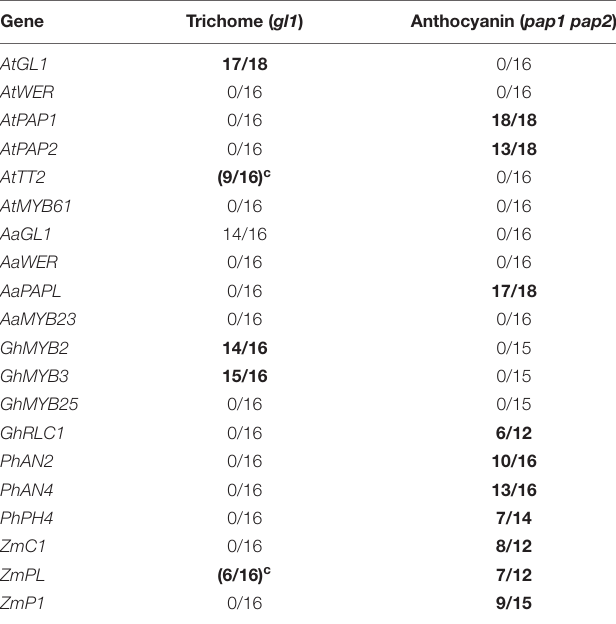
TABLE 4 | T1 or T2 lines transformed by pAMPAT-35S-R2R3MYB showing phenotypic rescue (rescued lines/total number of lines) in gl1 single mutant or pap1pap2